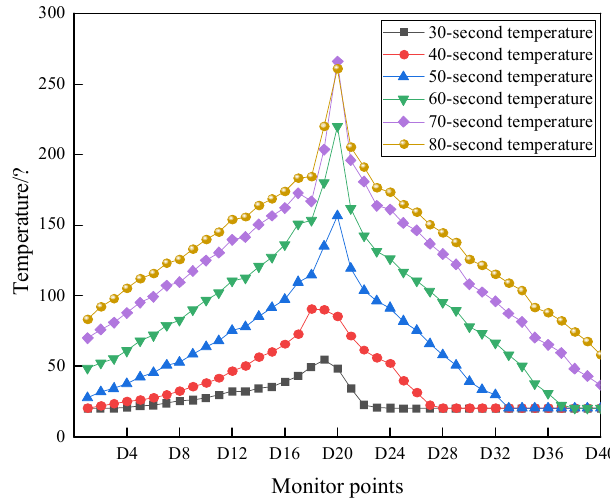
Figure 4. Temperature change chart of the diagonal branch at different times.